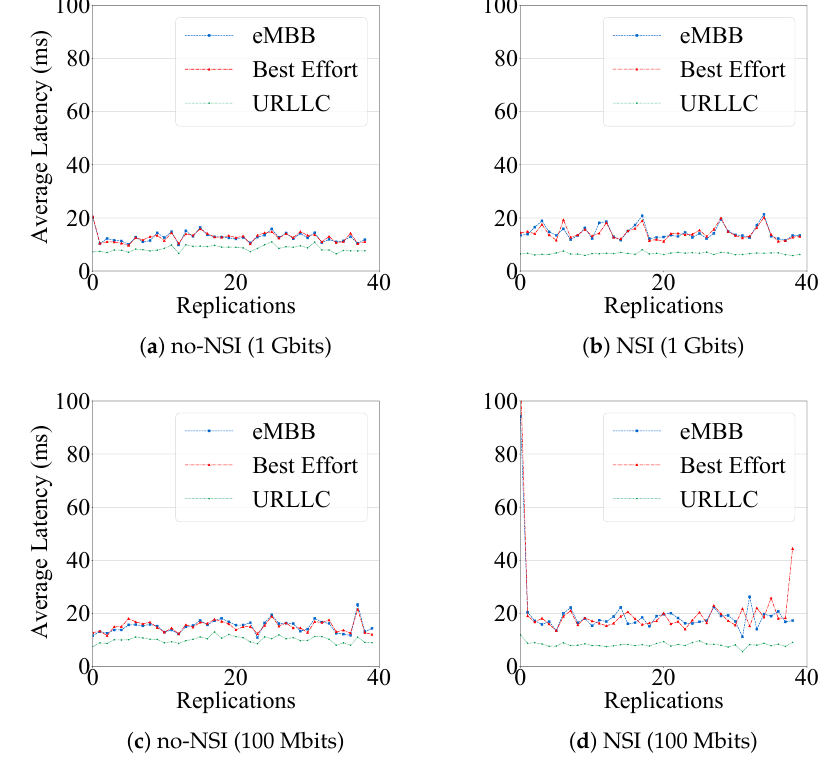
Figure 6. Average Latency.